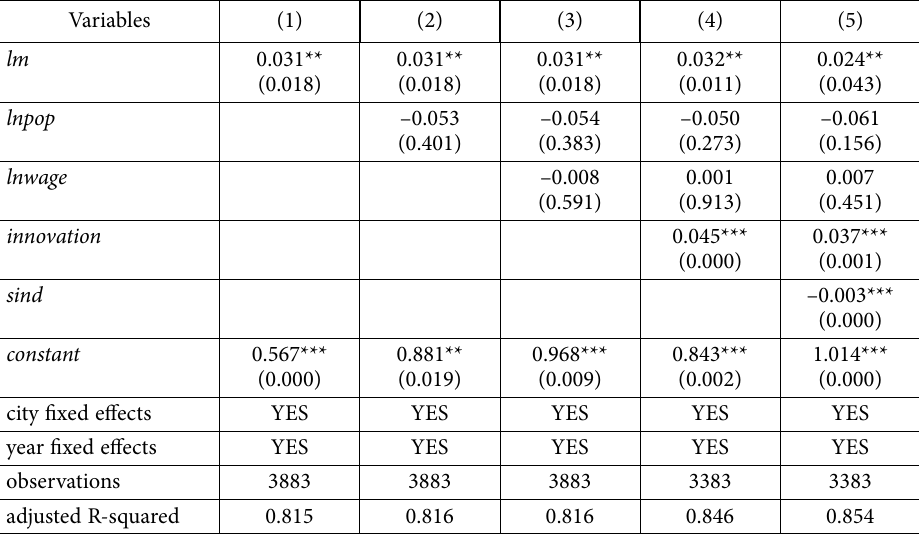
Table 3. The effects of land marketization on